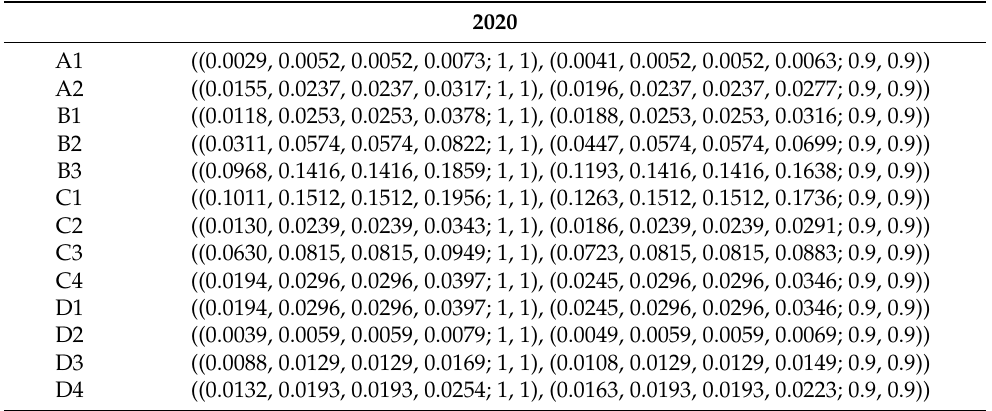
Table 17. Expert rating aggregation form (2020).